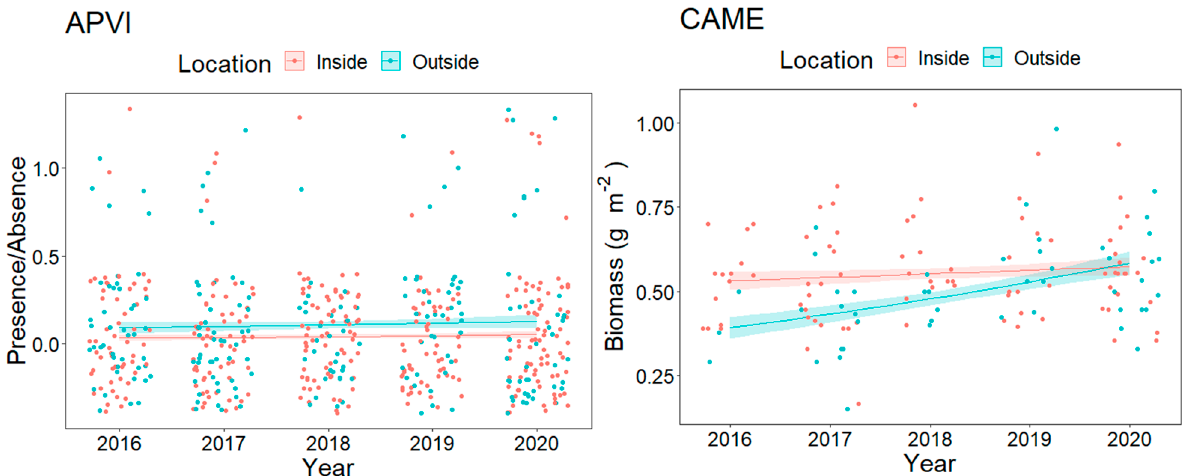
Figure 4. Generalized linear model (GLM) plots of significant trends in both presence/absence and biomass between locations (APVI-presence/absence and CAME-biomass), and among years (CAME-biomass). Species codes are as follows: A. virescens (APVI) and C. melanpygus (CAME).